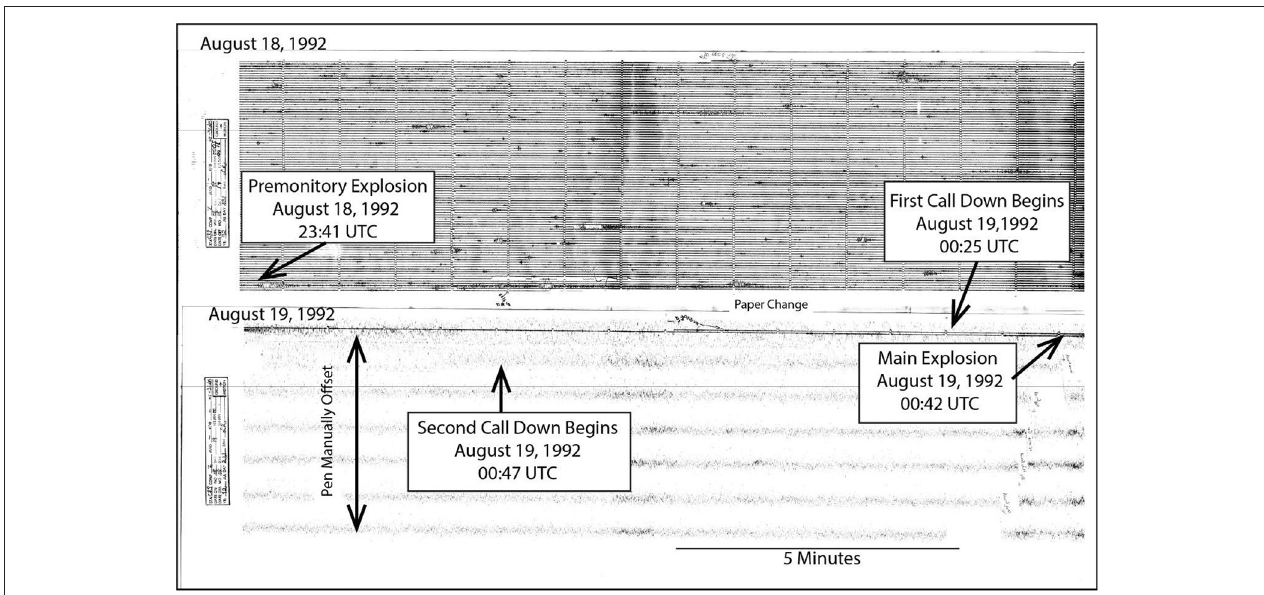
FIGURE 4 | Drum records from station CRP between 00:05 UTC August 18 and 02:25 UTC on August 19, 1992 that show both the premonitory explosion at 23:41 on August 18 and the main explosion at 00:42 on August 19. Time marks represent 1min intervals. These records show 26h and 20min of seismic data and the paper on the drum was changed between 00:16 and 00:21 UTC on August 19. Times of call downs at 00:25 and 00:47 UTC are also noted and followed the explosions onset by 44 and 5min, respectively. Following the onset of the main explosion at 00:42 the drum recorder pen was manually offset to prevent the high amplitude explosion signal from over writing the record on the